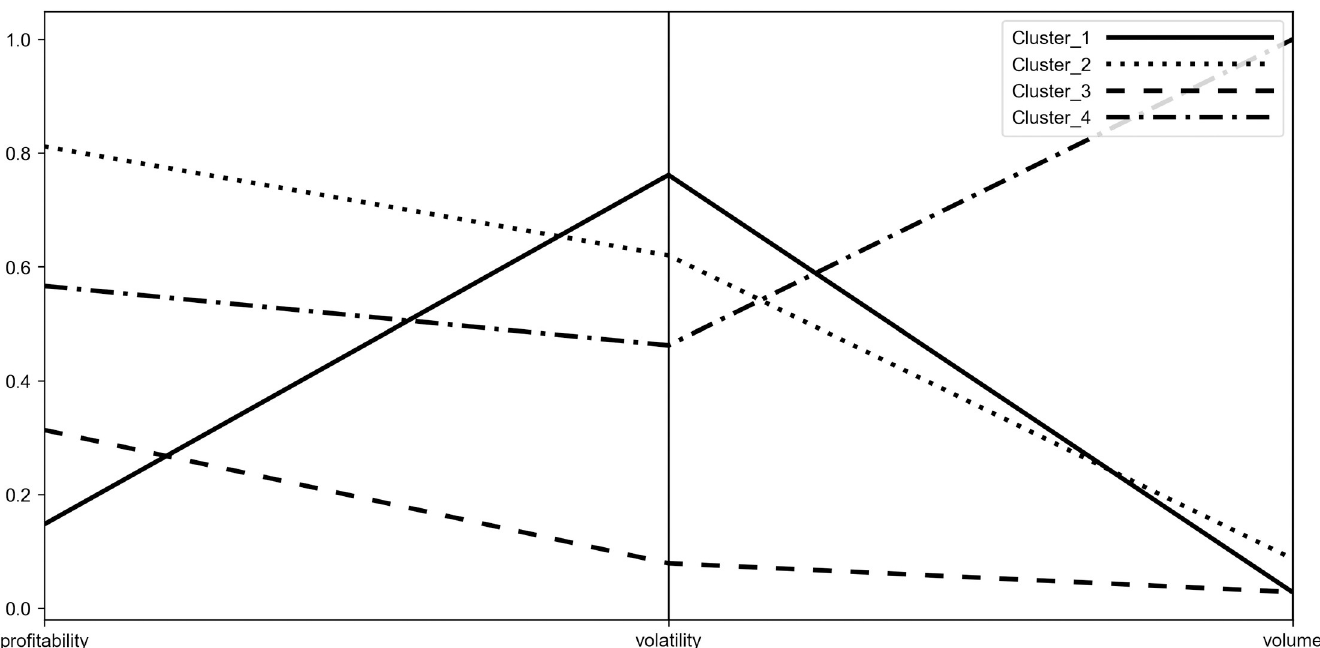
Fig 9. Parallel coordinate plot for